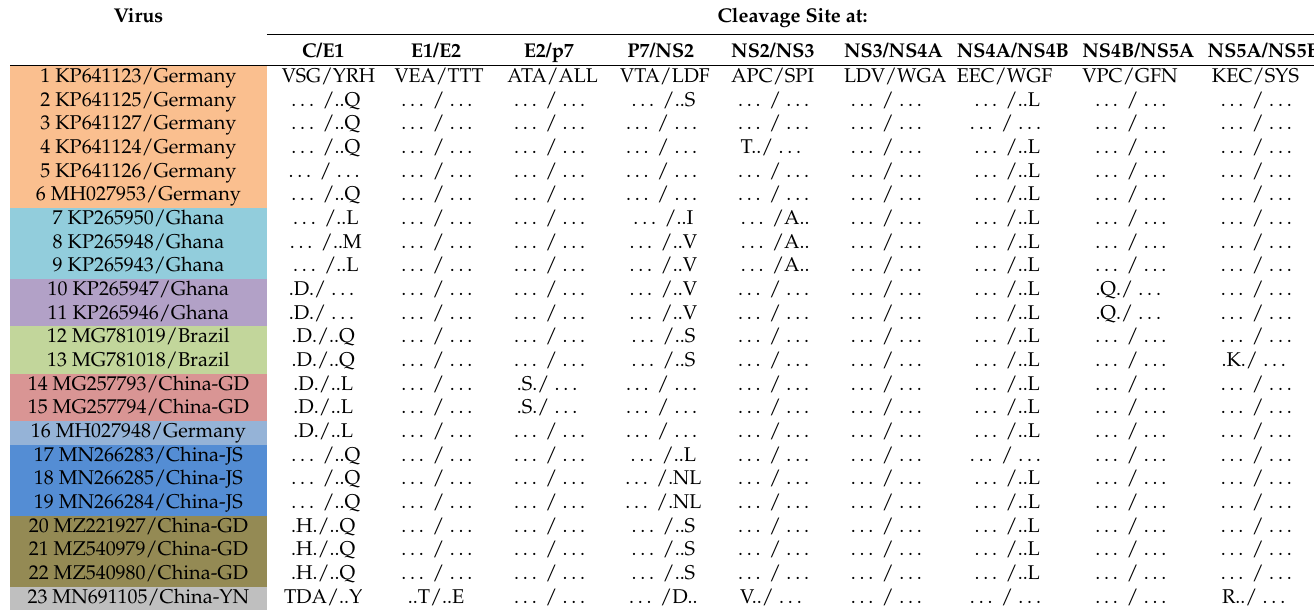
Table 1. Comparison of predicted BovHepV polyprotein cleavage sites. Virus